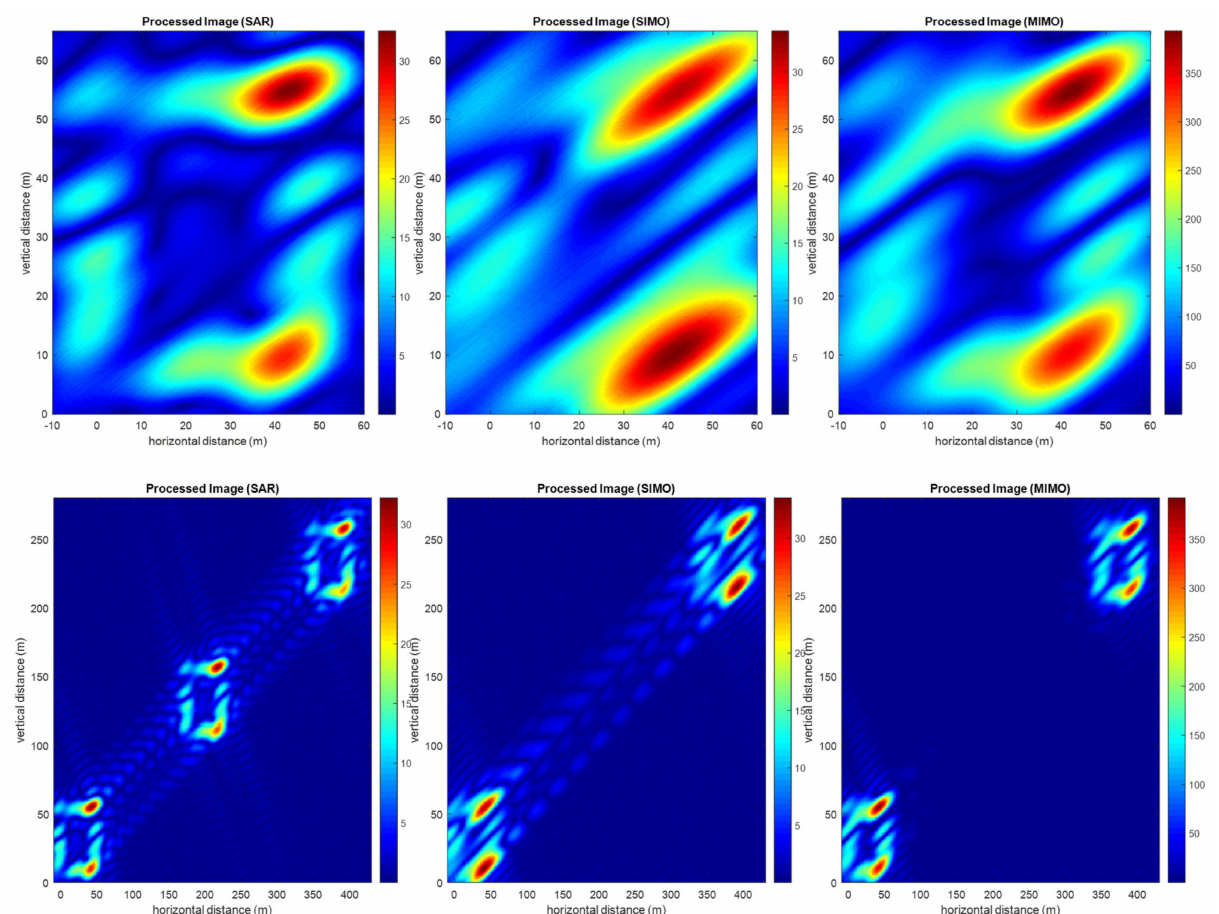
Figure 24. The simulated 2D images for Example 3 for SAR/SIMO/MIMO modes. Upper row: fine scene resolution (20 cm), small scene extent. Lower row: coarse scene resolution (1 m), large scene extent.